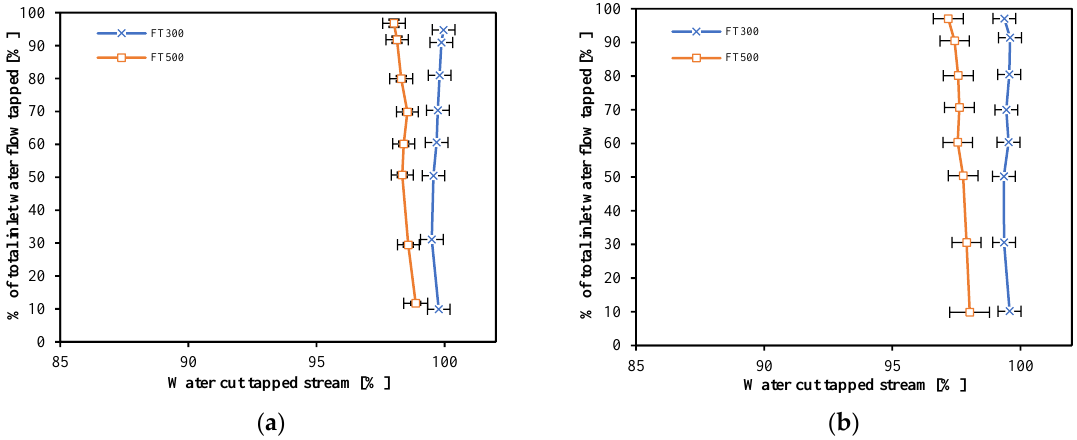
Figure 15. Drainage potential for ( a ) unspiked, ( b ) spiked oil and water at WC inlet 90%, total flow rate of 300, and 500 L/min.